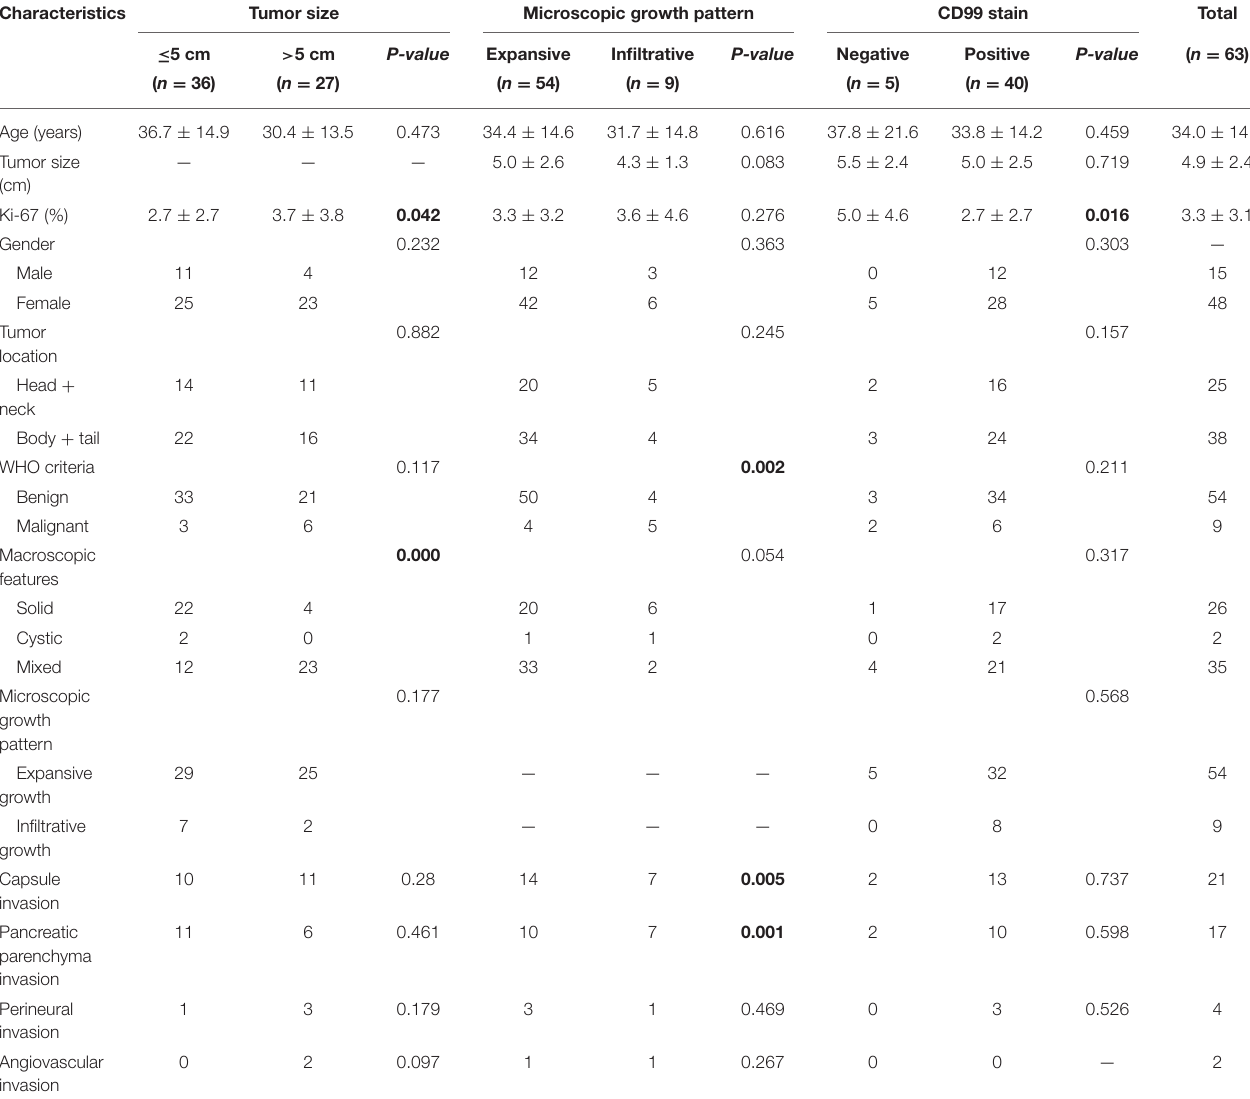
Bold values indicate statistical